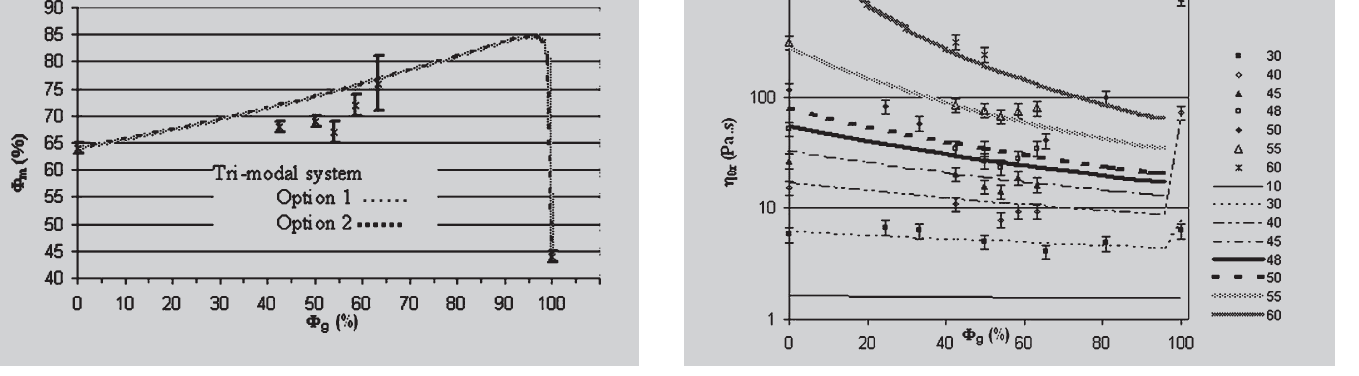
Figure 10 (left): Prediction of F based on m Pishvaei’s model for a tri- modal system with Option 1 ( F = 44.0 %, F = m(large) m(medium) 44.0 % and F = 52.4 %) m(small) and Option 2 ( F = 44.0 m(large) %, F = 51.8 % and m(medium) F = 51.8 %). m(small) Figure 11: Modelling h as a function 0 of medium (15 μm) and small (2 μm) size particles of F for a tri-modal system. g Table 3: Values of intrinsic viscosity calculated from the best fit of the Krieger-Dougherty equation and from Eq.